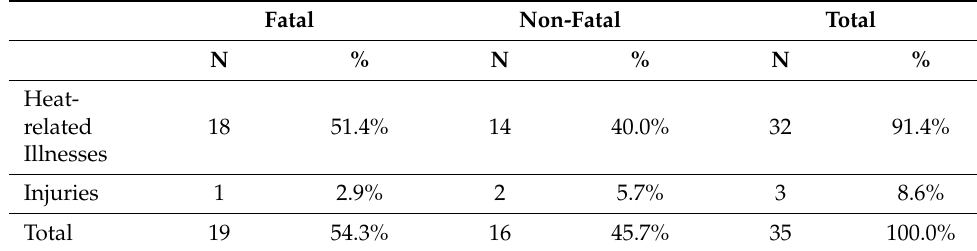
Table 2. Severity of heat-related illnesses and injuries as reported by Italian online newspapers in